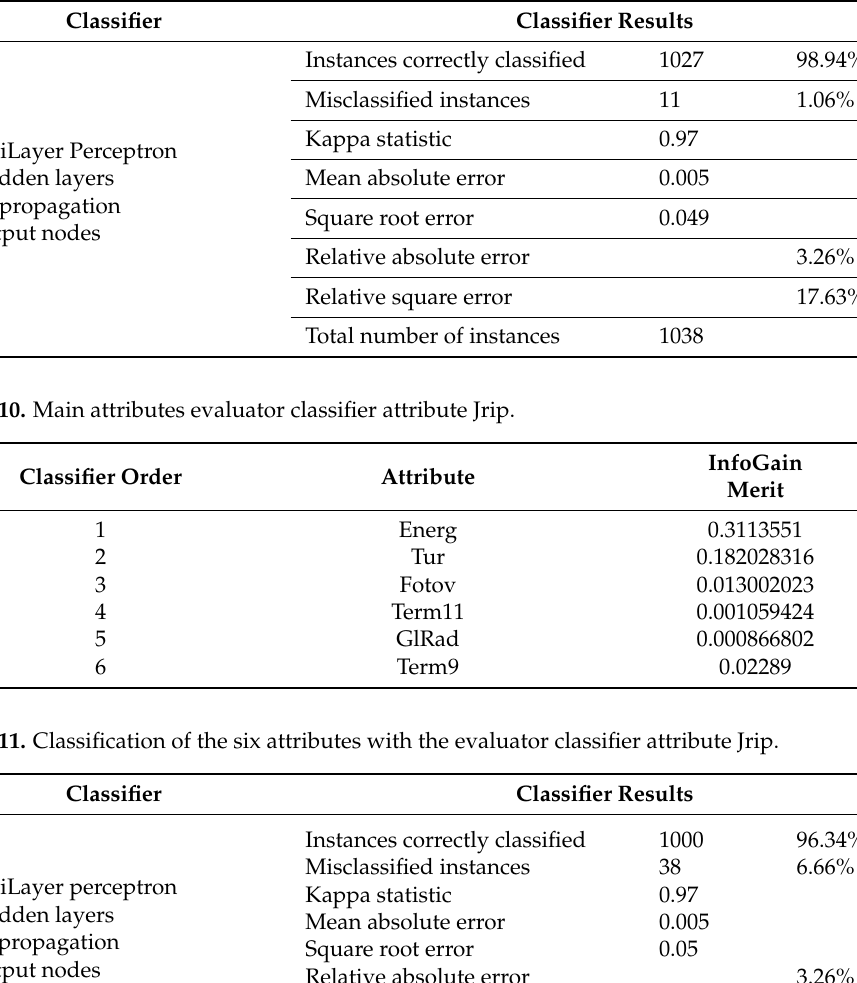
Table 9. Classification of the six attributes with the Infogain evaluator.